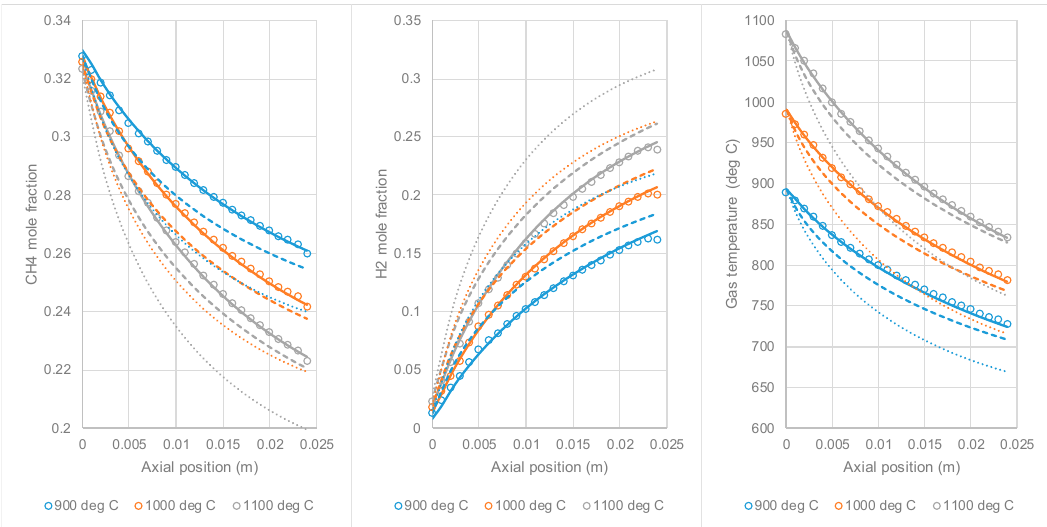
Figure 3. Comparisons of different 1D model formulations to PR-DNS data at three different inlet temperatures. In each graph, the circles represent the PR-DNS results, the solid lines represent the full 1D model with all the proposed adjustments, the dashed lines represent the exclusion of the adjustment for the varying reaction rate constant (Equation (13)), and the dotted lines represent the exclusion of all model adjustments (Equations (12)–(14)).